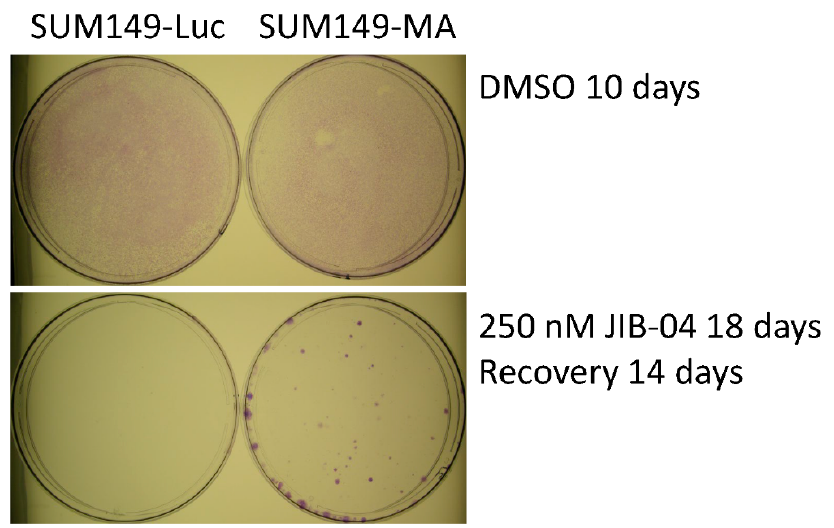
Figure 1. Resistance of SUM149-MA cells to treatment with JIB-04. SUM149-MA and parental SUM149-Luc cells were treated in parallel with 250 nM JIB-04 for 18 days (treatment killed most of the cells) and then allowed to recover and grow into colonies in a drug-free medium for 14 days before staining the colonies ( bottom ). The ( top ) panel shows the input control dishes from the treatment of cell cultures with the solvent DMSO for 10 days, which was when both cell cultures grew to comparable confluency as indicated by crystal violet staining.